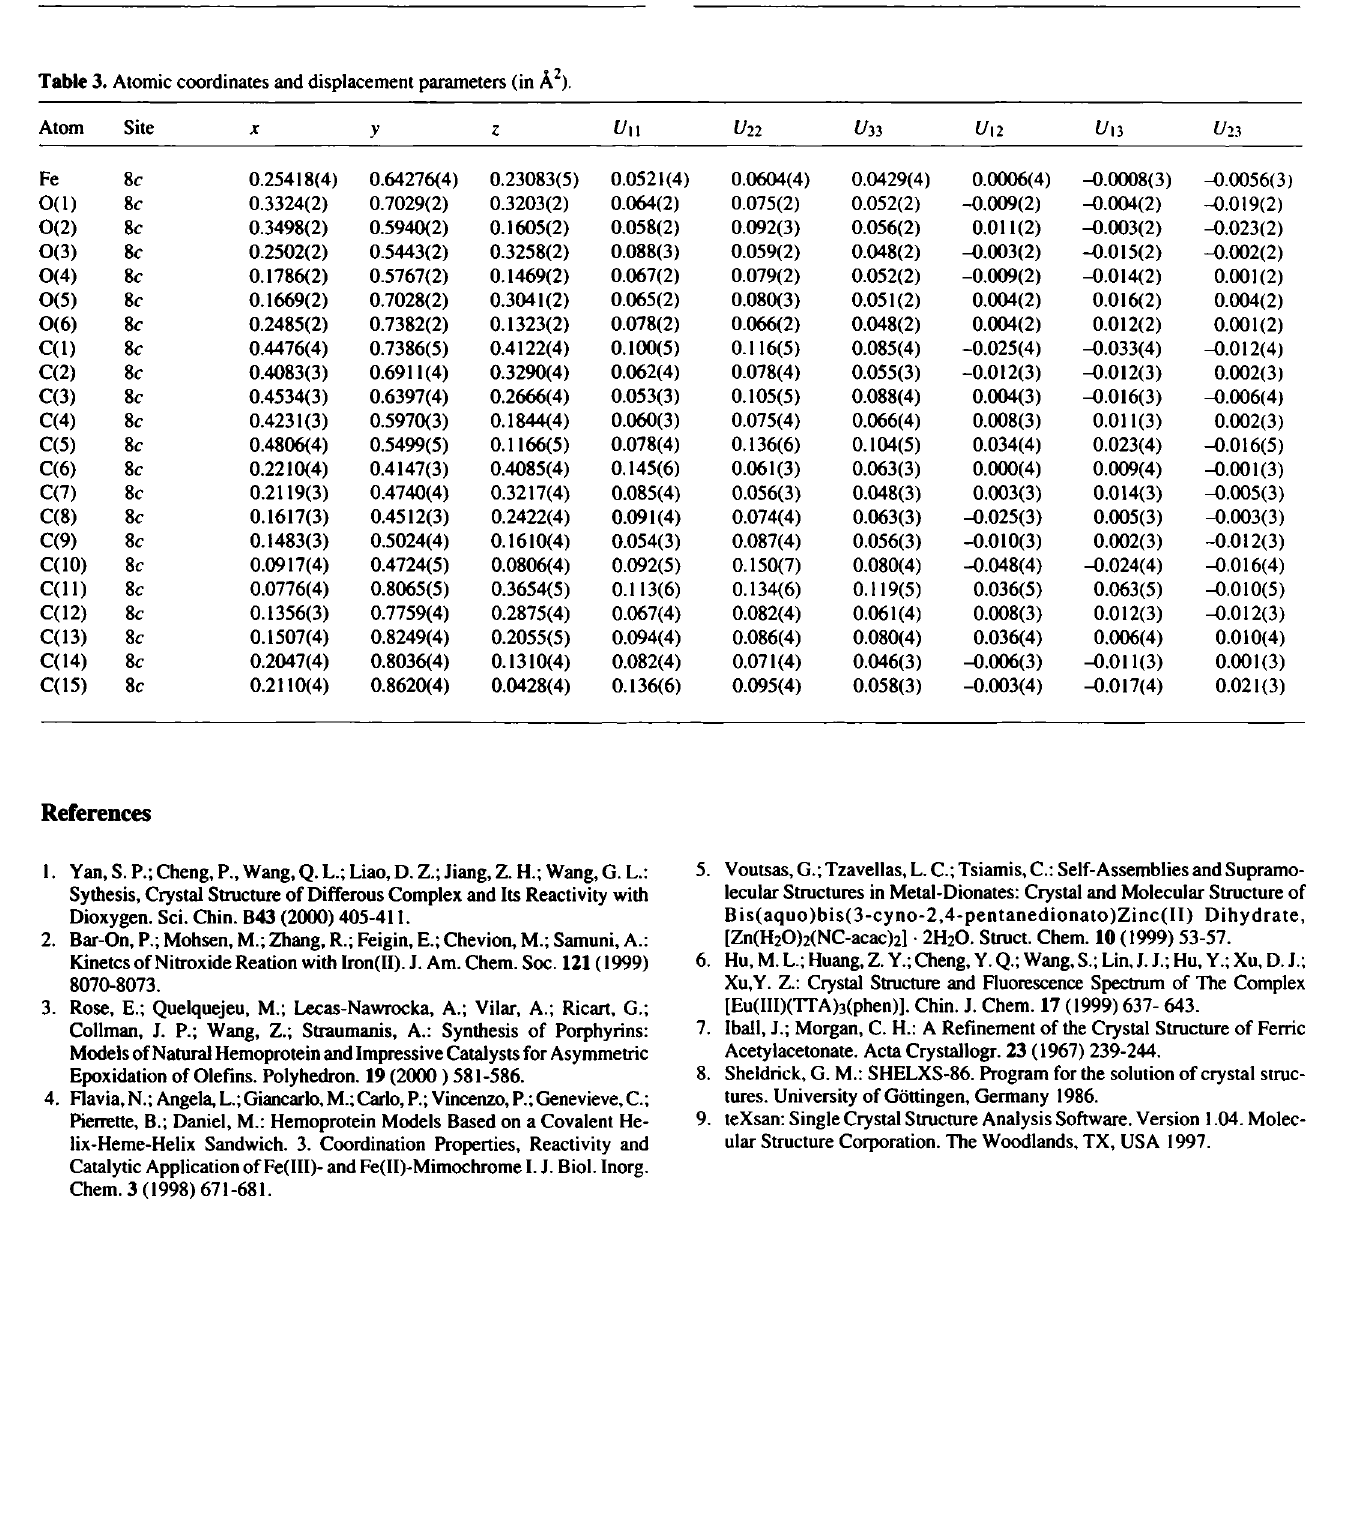
Table 3. Atomic coordinates and displacement parameters (in A 2